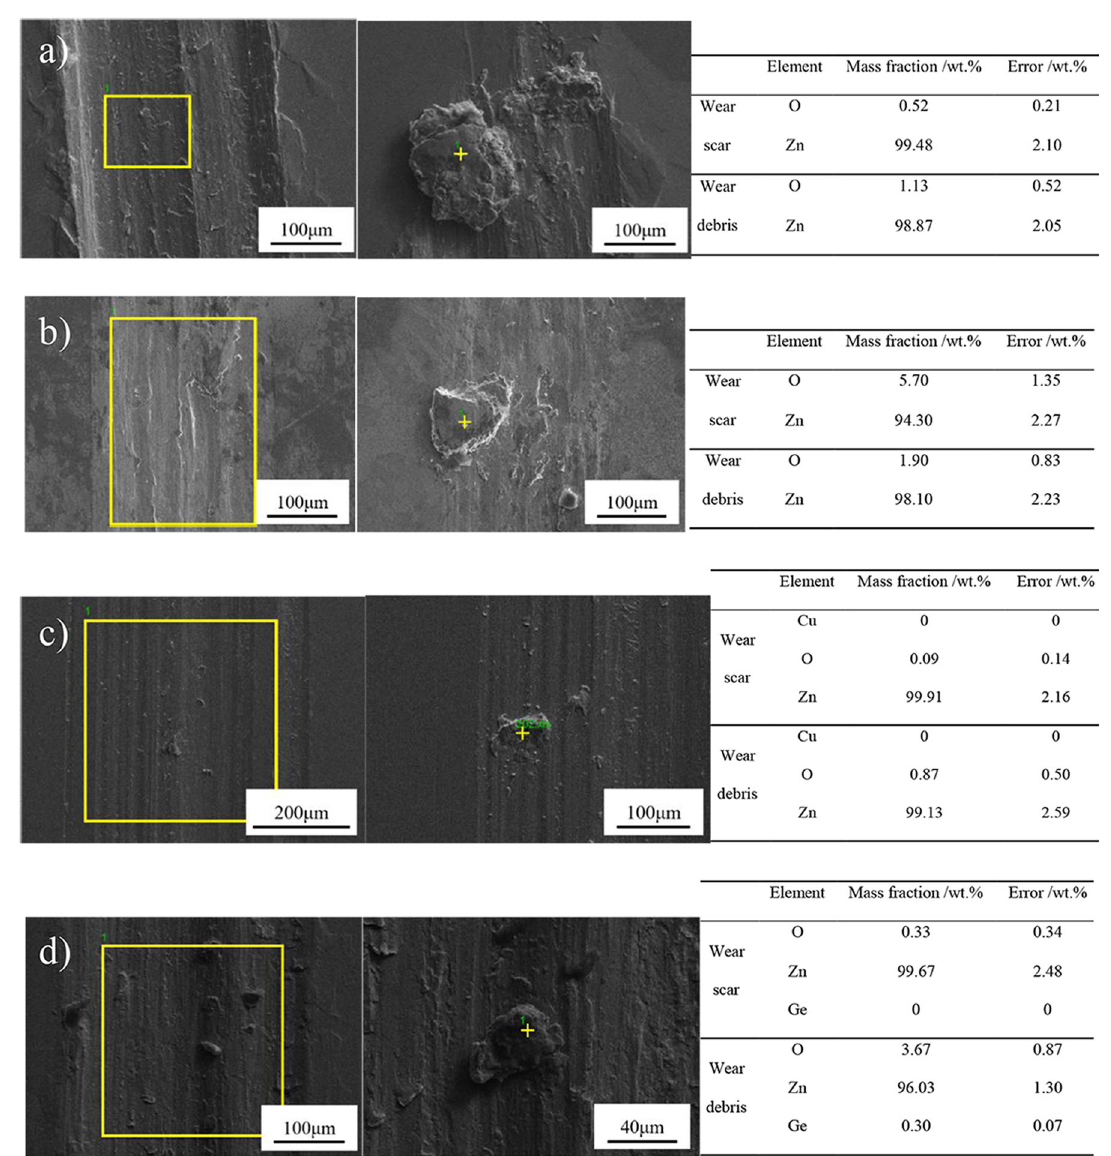
Fig. 4 Elemental distributions of wear scars and debris of samples tested under dry sliding condition analyzed by EDS: ( a ) pure Zn; ( b ) Zn-0.5Li; ( c ) Zn-1Cu; and ( d )